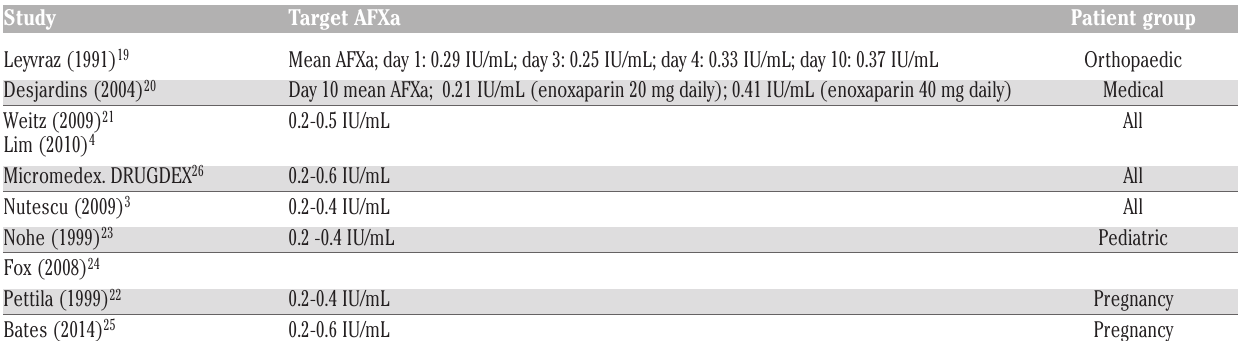
Table 2. Target anti-factor Xa ranges of prophylactic low molecular weight heparins. Study